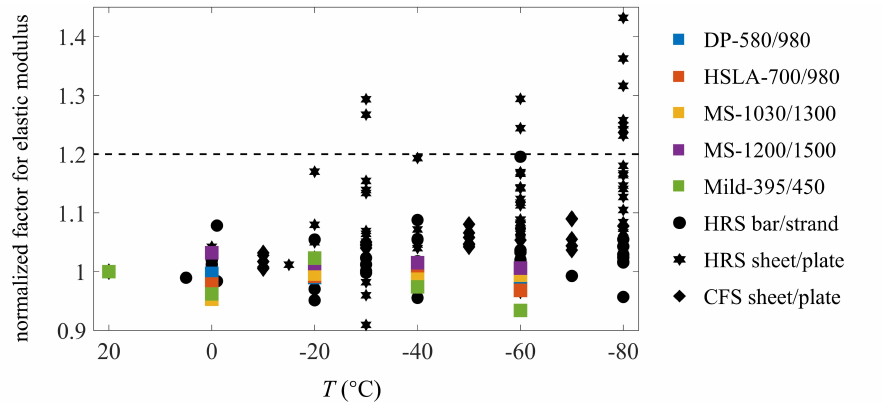
Figure 9. Normalized factors of elastic modulus for AHSS, HSLA-700/980, Mild-395/450, and data from published experiments. The dashed line represents an increase of 20% compared with